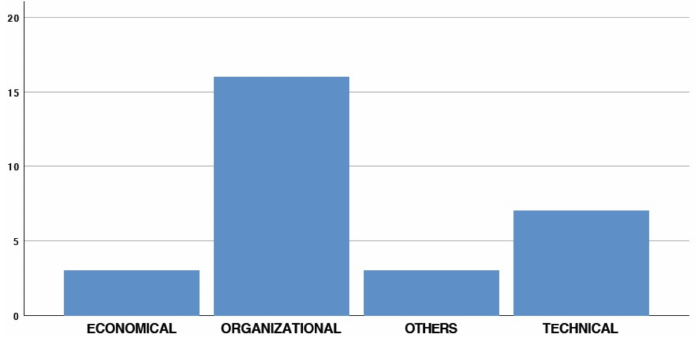
Figure 5. Perceived obstacles in overall EUS-GEA